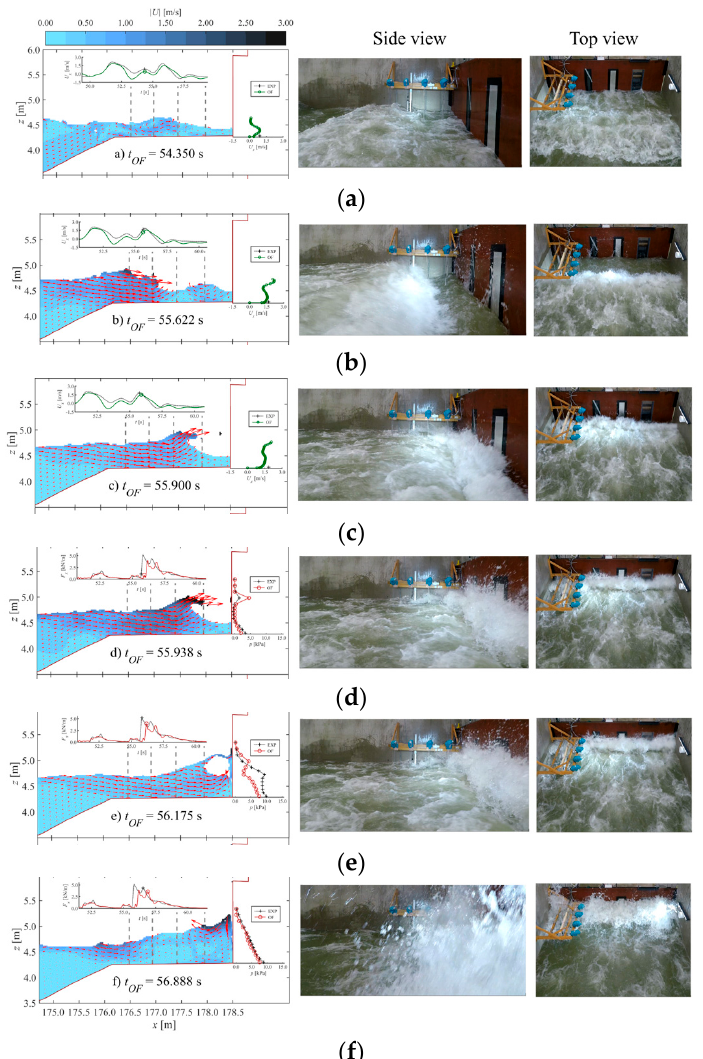
Figure 13. Snapshots of selected key time instants chronologically over the first main impact ( a – f ). The OF snapshot (left) is compared to the equivalent EXP snapshot from the side view (centre) and top view (right) cameras. In the OF snapshots, the colours of the water flow indicate the velocity magnitude | U | according to the colour scale shown at the top. The red arrows are the velocity vectors, which are scaled for a clear visualisation. Each OF snapshot has two inset graphs: at the top is a time series plot of U x (for EXP and U x for OF) ( a – c ) or F x ( d – f ), in which a circle marker (o) and a plus marker ( + ) indicate the time instant of the numerical and experimental snapshot, respectively. Along the vertical wall, U x ( a – c ) or p ( d – f ) is plotted at the respective ECM sensor location or each PS location (the vertical axis is z [m]). Along the promenade, four vertical grey dashed lines indicate the sensor locations on the promenade, of which the WLDM gauges are also visible in the experimental snapshots (topped by blue plastic bags). The location of the ECM is at the second vertical grey dashed line from the left. The time instant of the numerical snapshot is provided by t OF .